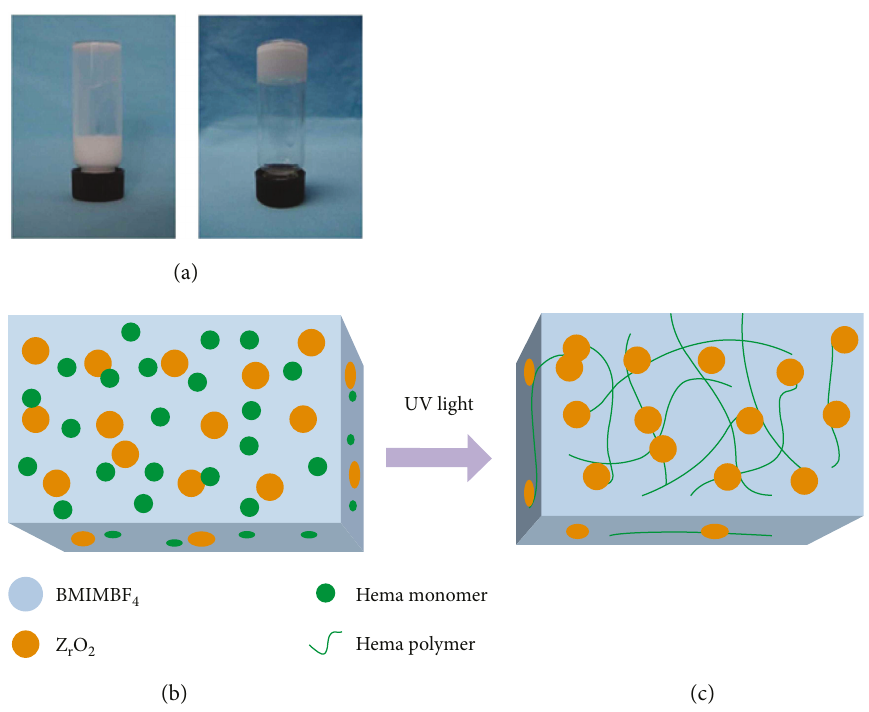
Figure 1: The proposed mechanism of the BMIMBF The ILG solution includes BMIMBF